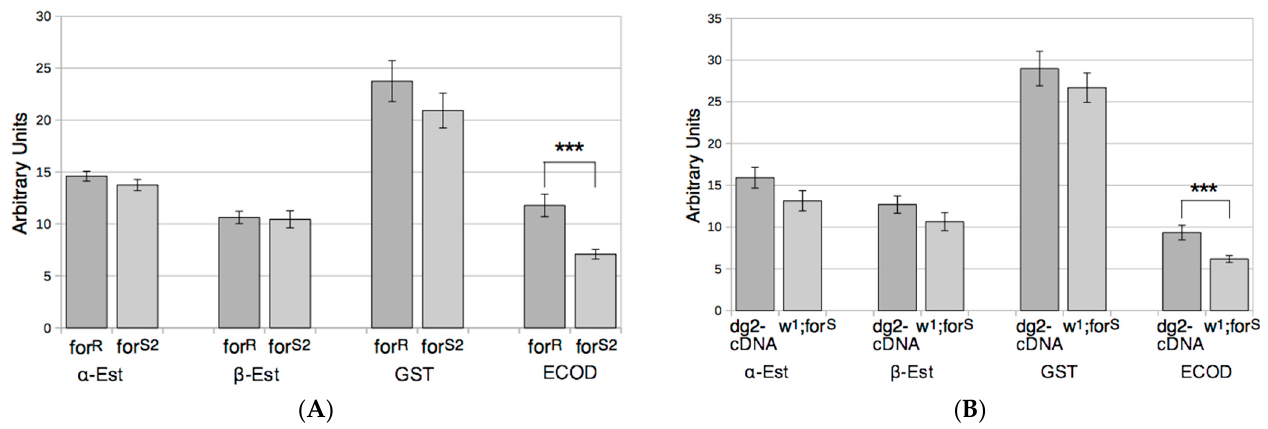
Figure 3. Activity levels of sterases, GSTs, and ECOD. Esterase activities are expressed in arbitrary units of O.D./fly/30 min, GSTs activity is expressed in arbitrary units of fluorescence/abdomen/40 min and ECOD activity is expressed in arbitrary units of fluorescence /abdomen/120 min. Results from genetically related strains are grouped in panel ( A ) ( for R and for S2 ) and panel ( B ) ( dg2 -cDNA and w 1 ;for S ). The vertical bars represent the standard error of the measurements. *** indicate significantly different activity values at p < 0.005. Dark grey boxes indicate rover strains and light grey boxes indicate sitter strains.